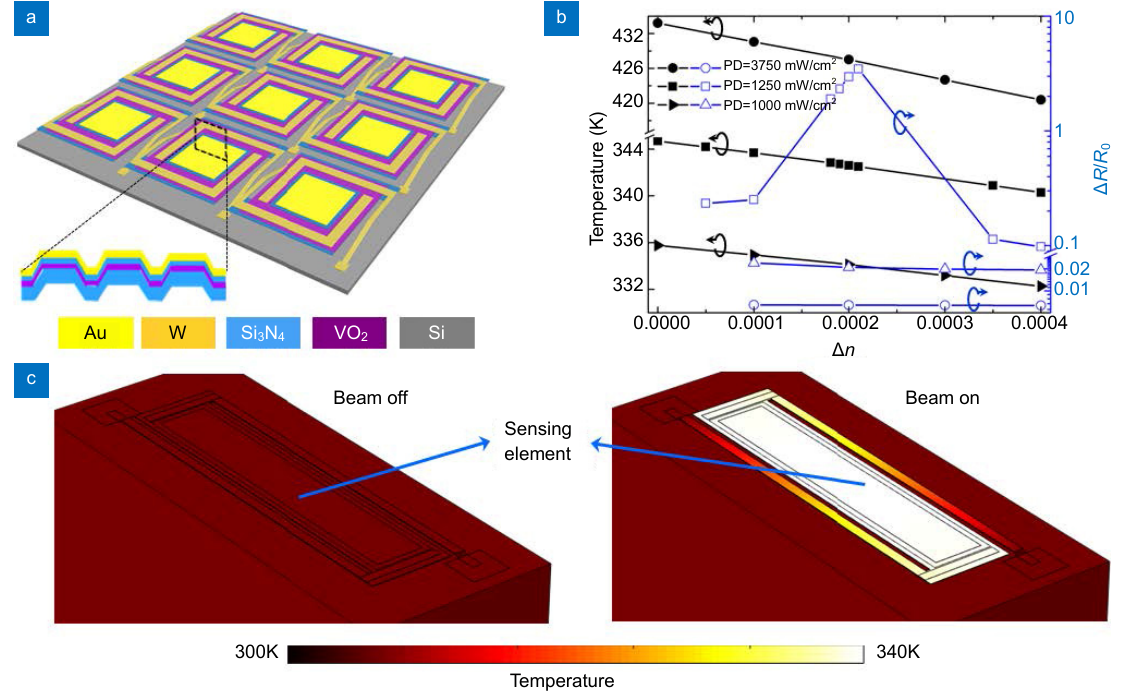
Fig. 4 | ( a ) Schematic of on-chip mid-IR gas sensor array based on an air bridge structure. The grating region has a size of 330 µm × 50 µm. The Au/Si 3 N 4 /VO 2 /Si 3 N 4 stack is shown in the inset and the thicknesses are 200 nm/50 nm/100 nm/500 nm, respectively. The stack is supported by the Si 3 N 4 /W bridges on Si substrate. ( b ) Temperature and relative electrical resistance variation of the sensors versus the variation of differ- ent environment gas RI. ‘PD’ means the power density of the incident light. ( c ) Simulated temperature distribution across the sensor with and without illumination at a wavelength of 3.348 µm with a power density of 1 W/cm 2 and the absorption is